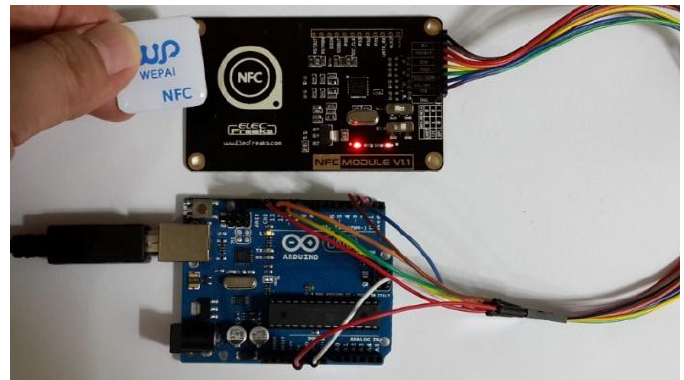
Figure 30. Relevant data or configuration written to a tag using NFC hardware